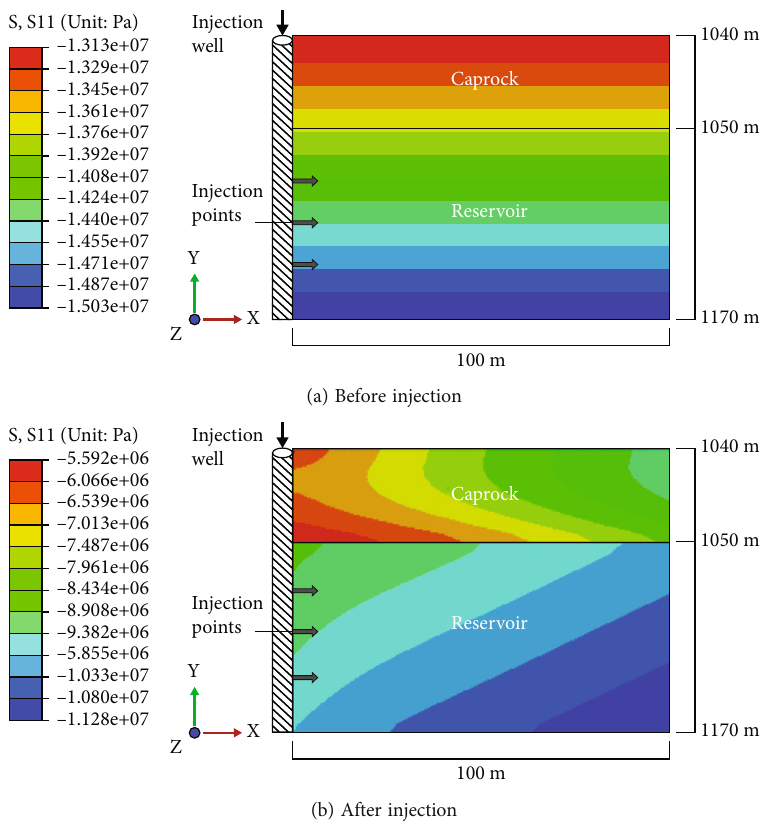
Figure 5: Horizontal stress